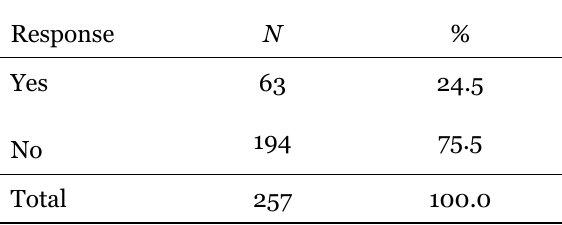
Lecturer Opinion on the Consistency of ODeL Delivery across Geographical Locations